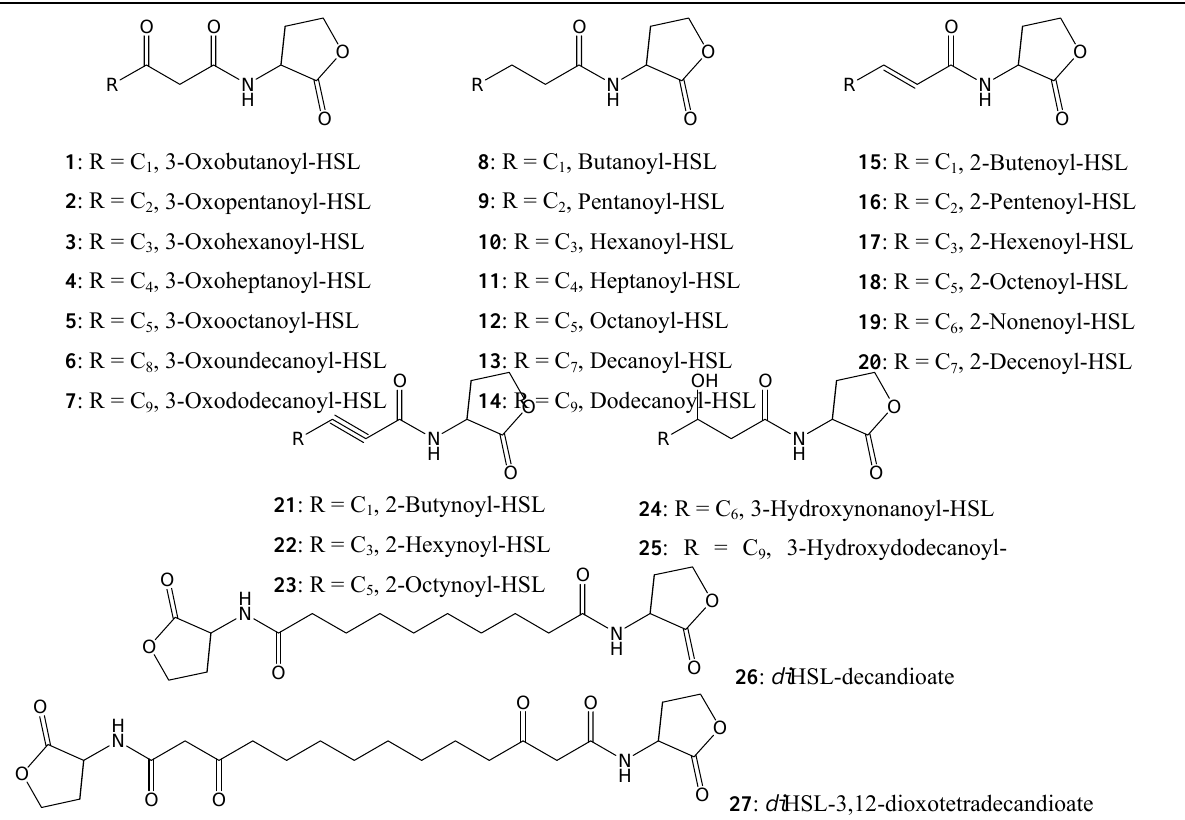
Figure 4. Chemical structures of AHL compounds used in the docking study modified from